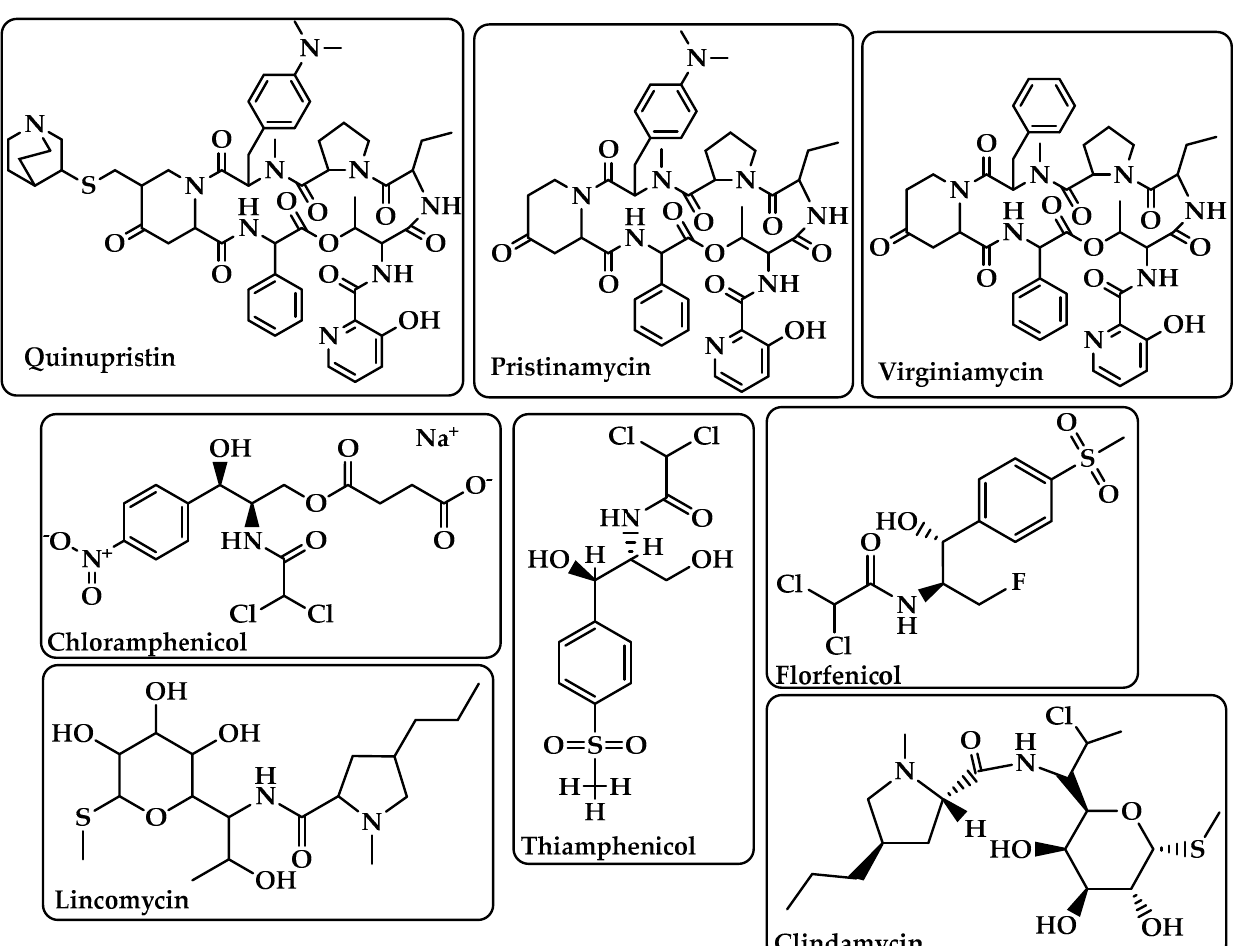
Figure 6. Chemical structure of quinupristin, pristinamycin, virginiamycin, chloramphenicol, thiamphenicol, fl orfenicol, lincomycin, and clindamycin .